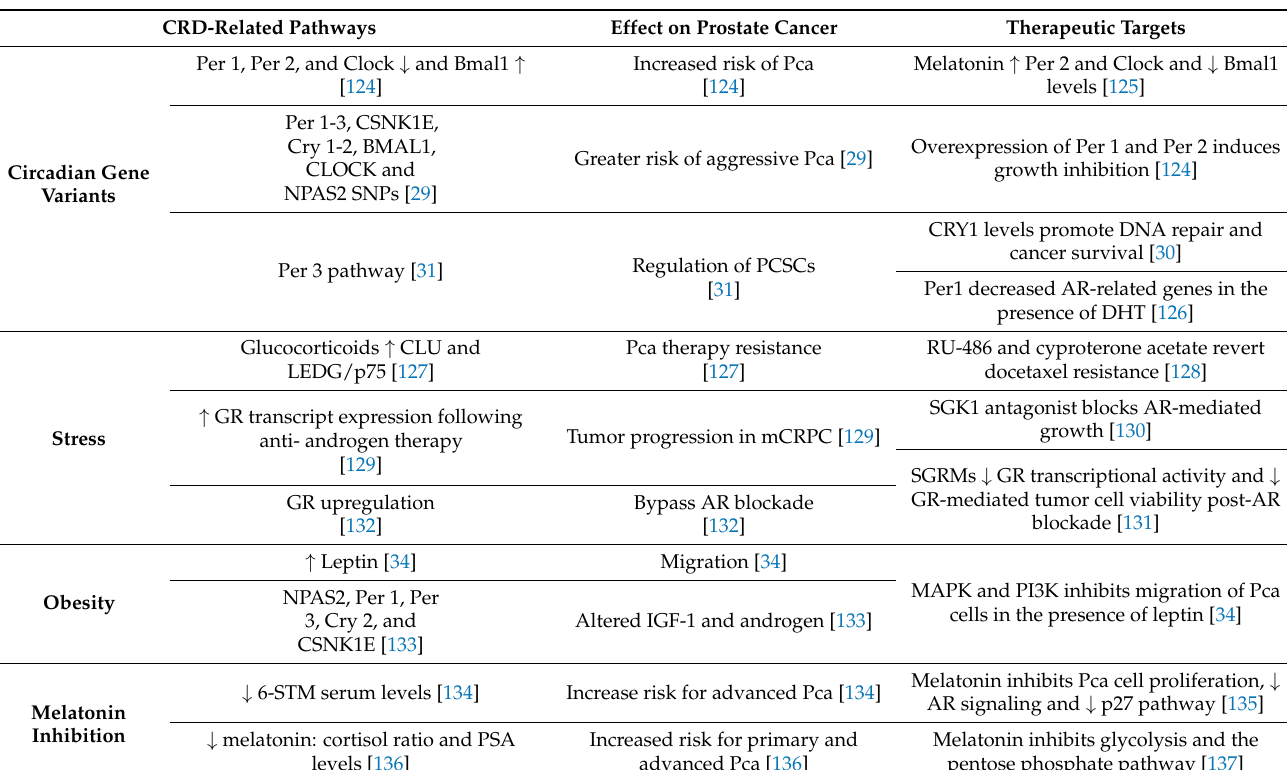
Table 1. Biological Pathways Linking CRDs and Prostate Cancer. The table provides a summary of pathways in which CRDs contribute to prostate cancer incidence and outcomes. The upward arrow refers to pathways, genes, or proteins that are upregulated, while the downward arrow refers to downregulated pathways, genes, or